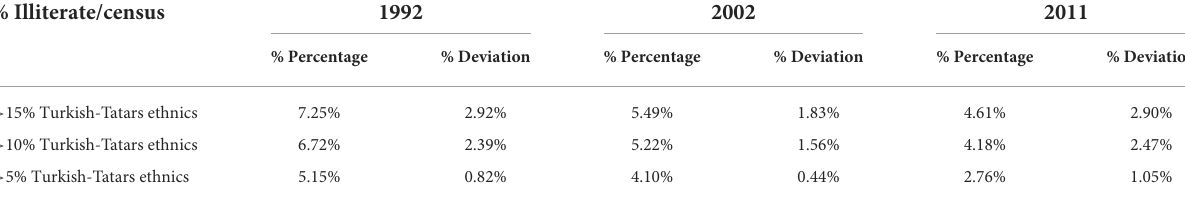
TABLE 4 Distribution of illiterate percentages and deviations in communes with 5– > 15% Turkish-Tatars ethnics.